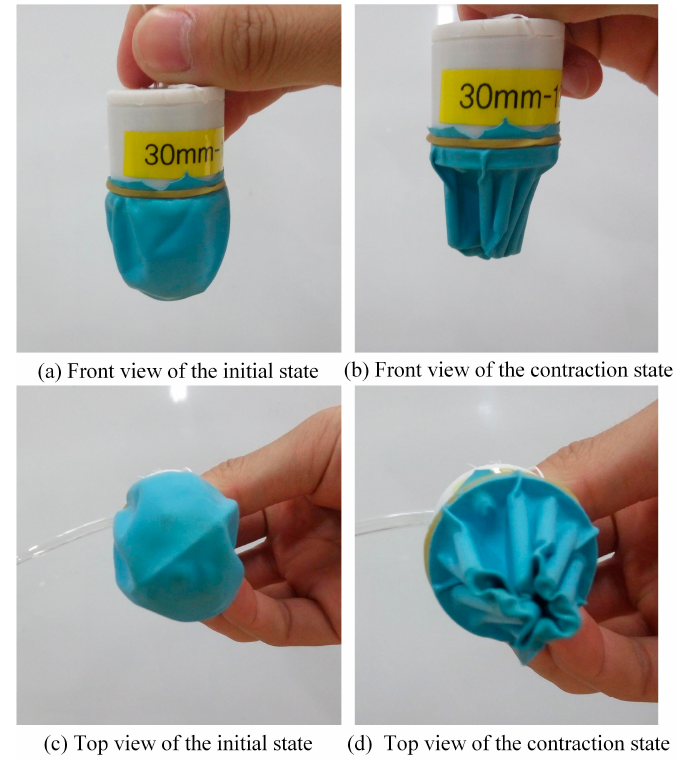
Figure 15. The comparison of contraction state and initial state.